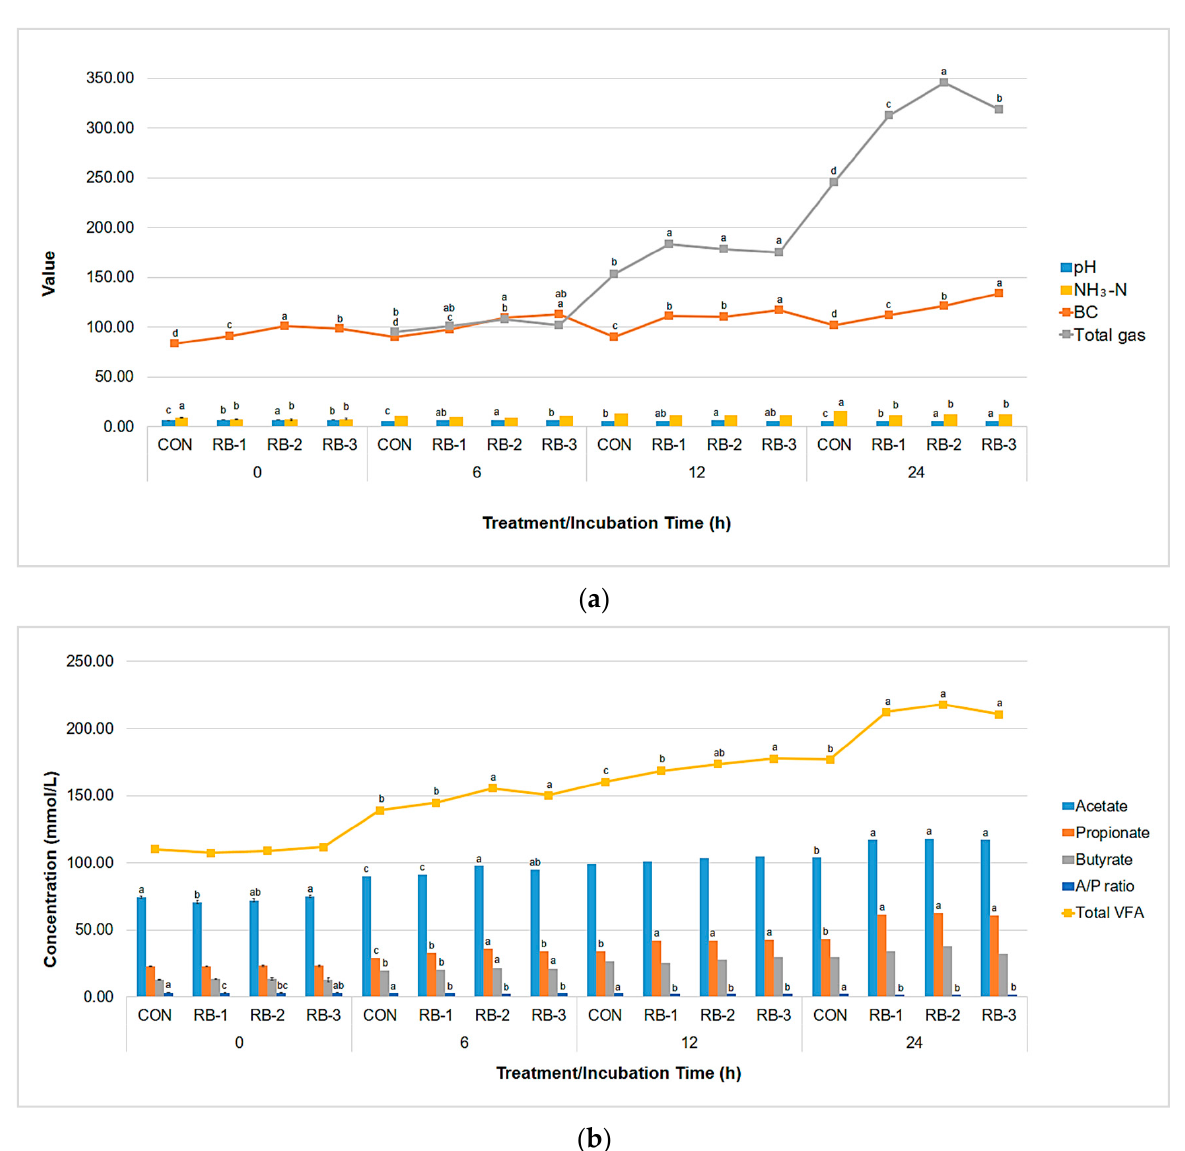
Figure 2. Effect of treatments on in vitro rumen fermentation parameters after 0, 6, 12, and 24 h of incubation. ( a ) effect on pH, NH 3 -N (mg/dL), BC (meq/L), and total gas (mL). ( b ) effect on individual and total VFA (mmol/L), and A/P ratio. CON, negative control; RB-1 (30% calcium oxide, 10% processed coral, 30% magnesium oxide, 30% sodium bicarbonate); RB-2 (20% calcium oxide, 10% processed coral, 30% magnesium oxide, 40% sodium bicarbonate); RB-3 (20% calcium oxide, 10% processed coral, 40% magnesium oxide, 30% sodium bicarbonate). a–d Superscript denotes significant differences ( p < 0.05). BC, buffering capacity; NH 3 -N, ammonia-nitrogen; VFA, volatile fatty acid; A/P, acetate to propionate